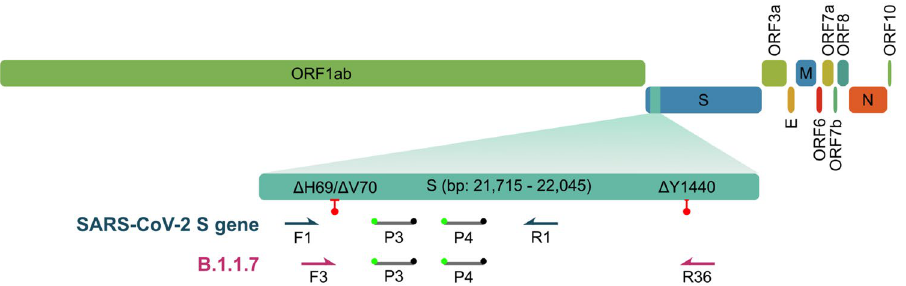
Figure 1. Development and optimization of a general SARS-CoV-2 S gene primer/probe set for all SARS- CoV-2 variants. Schematic illustrates genomic organization of SARS-CoV-2 with an emphasis on the location of both SARS-CoV-2 S gene and B.1.1.7 primer/probe sets relative to the ΔH69/ΔV70 and ΔY144 deletions (red lines with ball points) observed in the spike gene of B.1.1.7 variants.